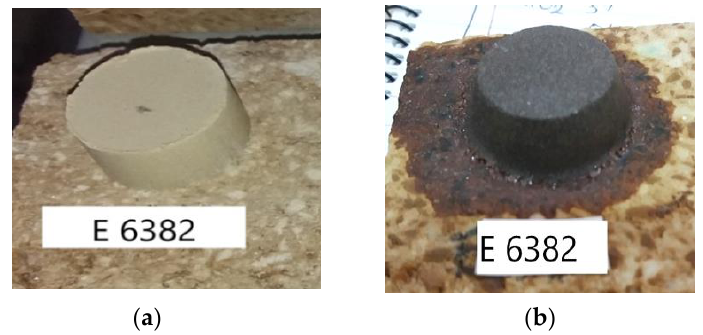
Figure 3. Peridotite sample E6382: ( a ) Before calcination; ( b ) after calcination.